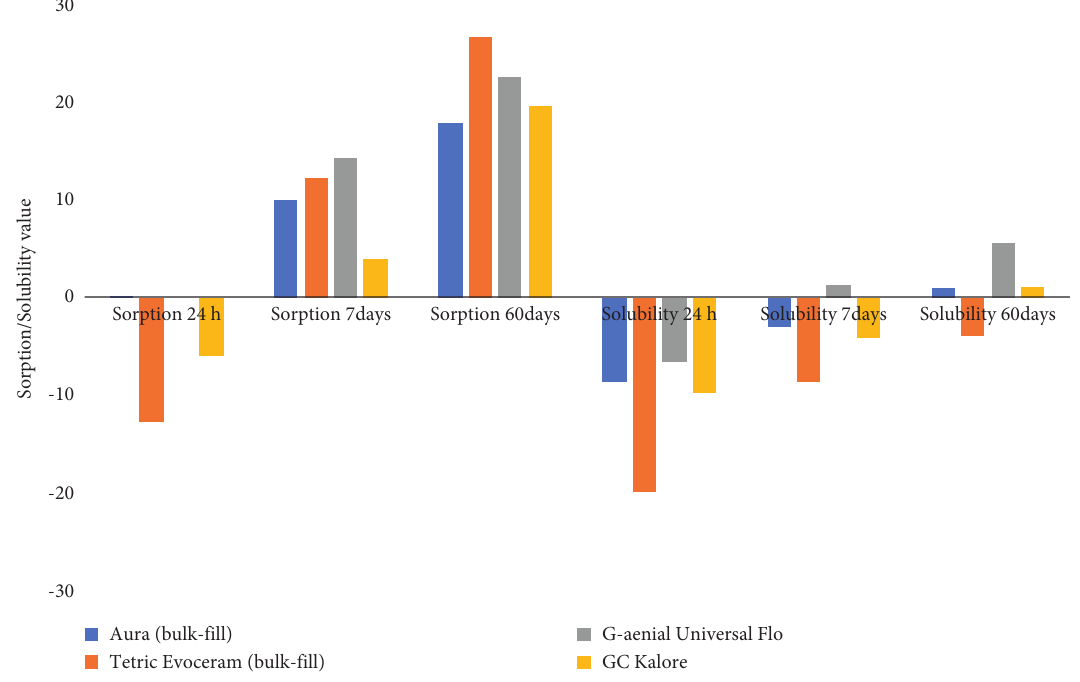
Figure 2: Mean values for Vickers microhardness of all materials. Table 4: Comparison of mean ± SD values of sorption and solubility between all materials after 3 storage times, analysed by ANOVA test.